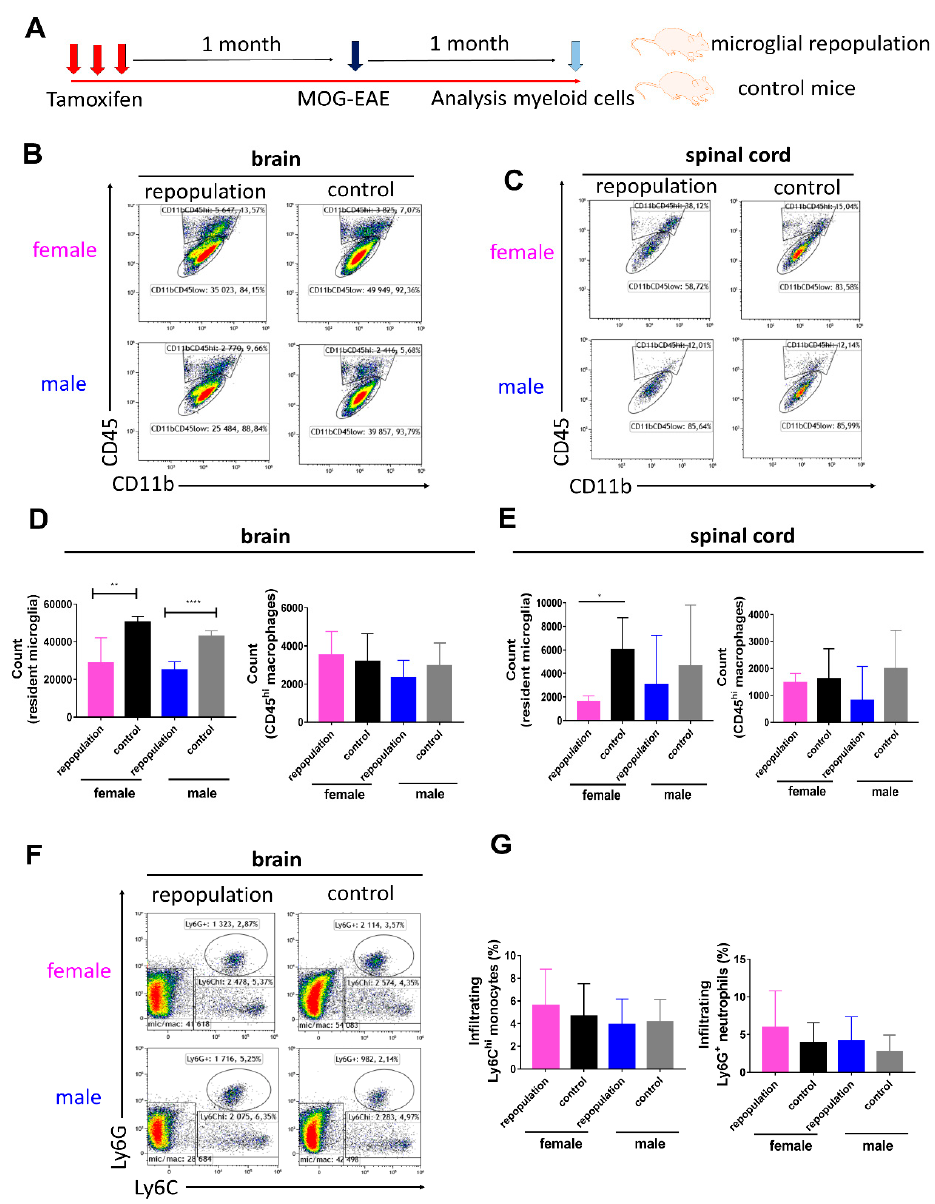
Figure 4. CNS myeloid cell compositions during chronic EAE ( A ) Schematic overview of the experimental design. One month after tamoxifen injections, EAE was induced by active immunization with MOG in Cx3cr1 CreER/+ Rosa26 DTA/+ mice with newly repopulated microglia and in Cx3cr1 CreER/+ mice with resident microglia (both male and female mice). Brain and spinal cord tissues were dissected on day 29 post-immunization (chronic EAE period). ( B , C ) Myeloid cell subset analysis in the brain ( B ) and spinal cord tissues ( C ) of the Cx3cr1 CreER/+ Rosa26 DTA/+ mice and Cx3cr1 CreER/+ mice were performed using flow cytometry. ( D ) The numbers of CD11b + CD45 low Ly6C − Ly6G − brain microglia and CD11b + CD45 hi Ly6C − Ly6G − macrophages in repopulated and control groups. n = 5 mice in each group. ( E ) The numbers of CD11b + CD45 low Ly6C − Ly6G − spinal cord microglia and CD11b + CD45 hi Ly6C − Ly6G − macrophages in repopulated and control groups. n = 3, 5, 4 and 4 mice in female repopulation, female control, male repopulation and male control group, respectively. ( F ) Representative flow cytometry plots of infiltrating Ly6C + monocytes and Ly6G + neutrophils in EAE brain tissues are depicted during the chronic EAE period. ( G ) Infiltrating Ly6C + monocyte and Ly6G + neutrophil proportions in EAE brains did not differ among different groups during chronic EAE period. Statistical significance is indicated as * p < 0.05, ** p < 0.01 and *** p < 0.001.